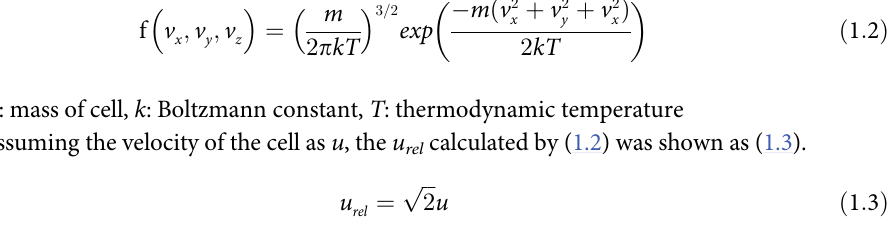
m : mass of cell, k : Boltzmann constant, T : thermodynamic temperature